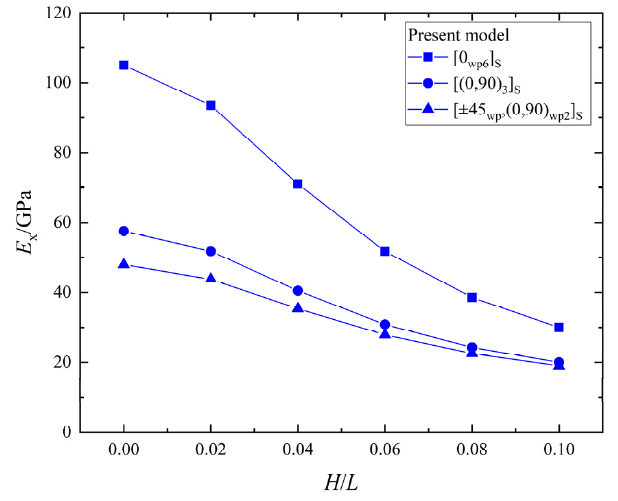
Figure 11. The effective elastic stiffness, E x , vs. wrinkle parameter, H/L , in laminates. The relationship between the effective elastic stiffness, E y , and the wrinkle defect parameter, H / L , of the laminates with the three different ply stacking sequences is shown in Figure 12. The E y of the [0 wp /90 wp ] 3 S and [ ± 45 wp ,(0,90) wp 2 ] S laminates decreases with the increase of H / L , and the maximum decrease percentages are 1.3% and 7.9%, respectively. However, the E y of the [0 wp 6 ] S laminate doesn’t change with H / L . Therefore, the wrinkle parameter, H / L , has the greatest effect on the E y of the [ ± 45 wp ,(0,90) wp 2 ] S laminate, the significant least effect on the E y of the [0 wp /90 wp ] 3 S laminate, and no effect on the E y of the [0 wp 6 ] S laminate.